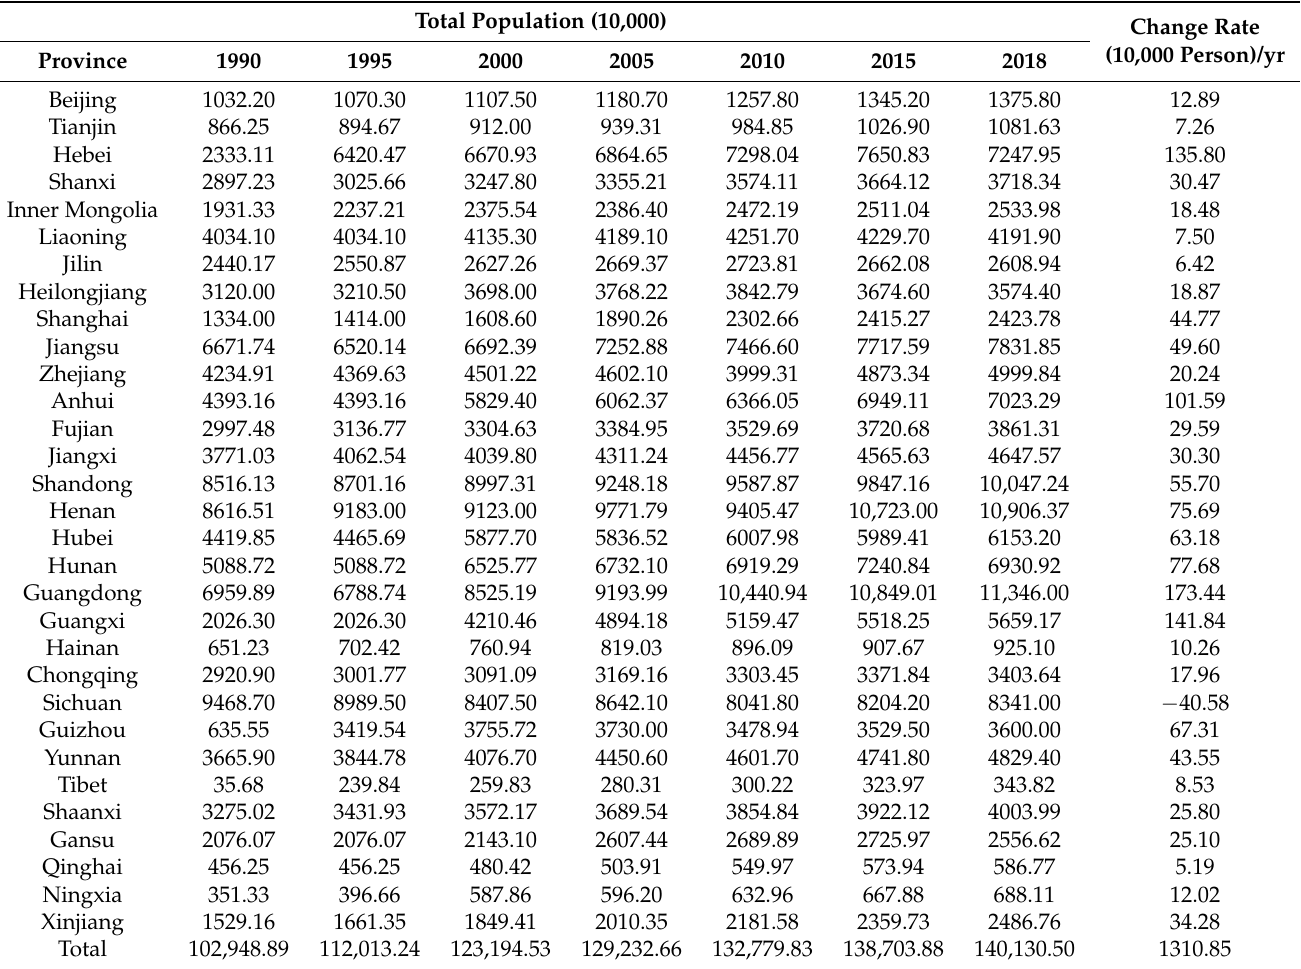
Table 2. The temporal dynamics of population in